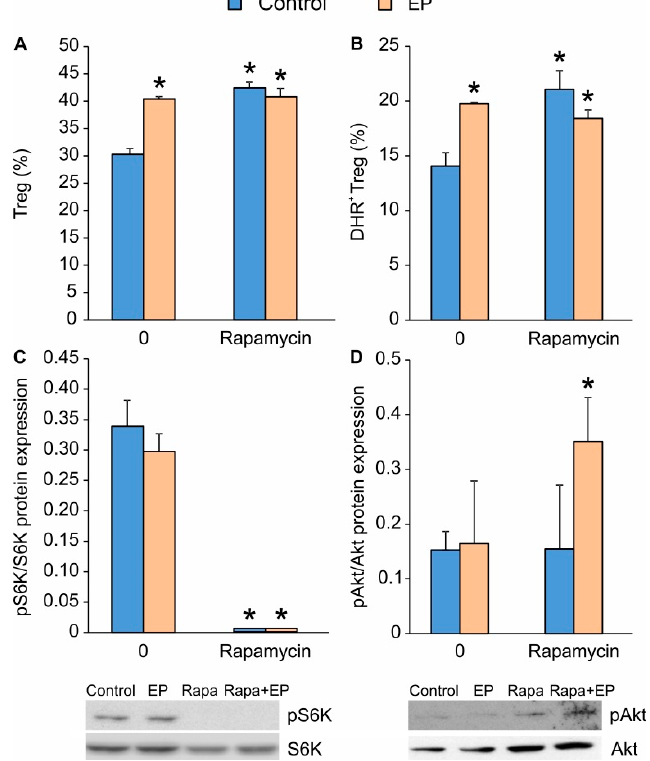
Figure 4. The influence of EP on mTOR activity. ( A ) The proportion of Treg (CD4 + CD25 high FoxP3 + ) and ( B ) the number of ROS-producing Treg (CD4 + CD25 high ) 72 h after the treatment with EP and/or rapamycin (Rapa). ( C ) The expression of phosphorylated S6K (pS6K) and ( D ) phosphorylated Akt (pAkt) normalized to the expression of total protein forms measured by immunoblot 72 h after EP and/or rapamycin administration. Representative blots are shown below the graph. * p < 0.05 represents the significant difference of EP- or rapamycin-treated cells in comparison to untreated control cells.